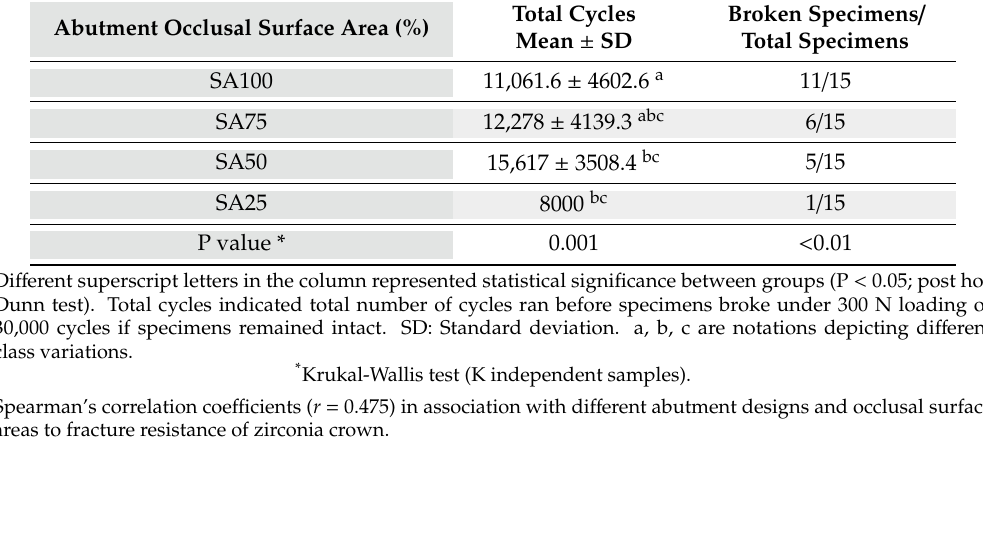
Table 1. Results of zirconia specimens on four occlusal surface areas of implant abutment after cycling test under vertical 300 N loading.